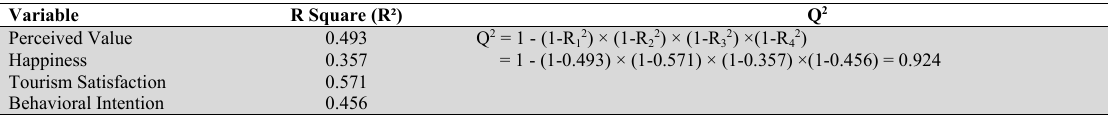
The Test result of Goodness of Fit Model